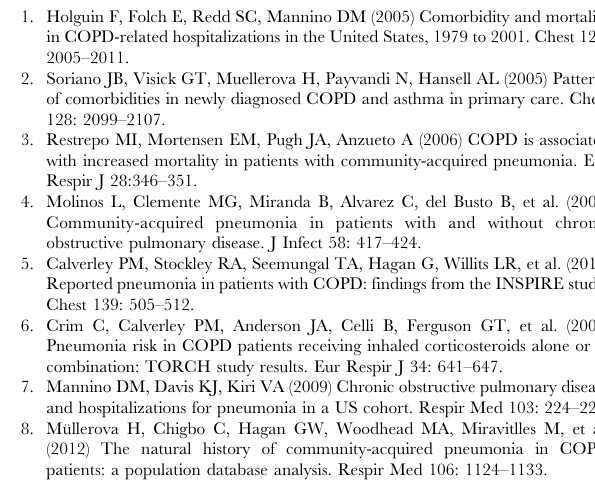
Table S1 ICD-10 pneumonia code used to identify pneumonia events. *Descriptions were taken directly from the ICD-10. Table S2 CPRD GOLD medcodes used to identify pneumonia. [X] Denotes the working diagnosis as recorded by the general practitioner. *Descriptions were taken directly from the CPRD- COPD. Table S3 ICD-10 pneumonia code recorded among 751 patients with pneumonia in new user cohort. 1. Patients may have multiple recordings of pneumonia codes. 2. HES ICD-10 codes recorded. *Descriptions were taken directly from the ICD- 10. Table S4 CPRD GOLD medcodes recorded among 751 patients with pneumonia. 1. Note that patients may have multiple recordings of pneumonia codes. 2. GPRD Medcodes recorded. *Descriptions were taken directly from the CPRD-COPD.